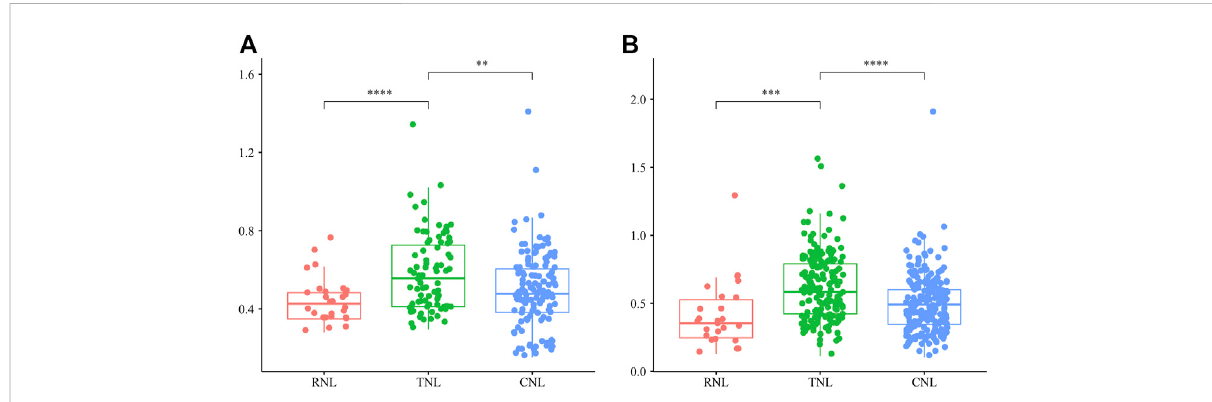
FIGURE 7 The Ka/Ks ratiosof NBS-LRR genepairs in12 Rosaceae genomes. (A) The Ka/Ks ratios ofintraspecies NBS-LRR pairs inthreesubclasses. (B) The Ka/Ks ratiosofinterspecies NBS-LRR pairsinthreesubclasses.Intheboxplot, themiddlelineindicates themedian, theboxindicatestherange ofthe 25 to 75th percentiles of the total data, the whiskers extend to data points less than 1.5 × IQR (interquartile range) away from the 1st/3rd